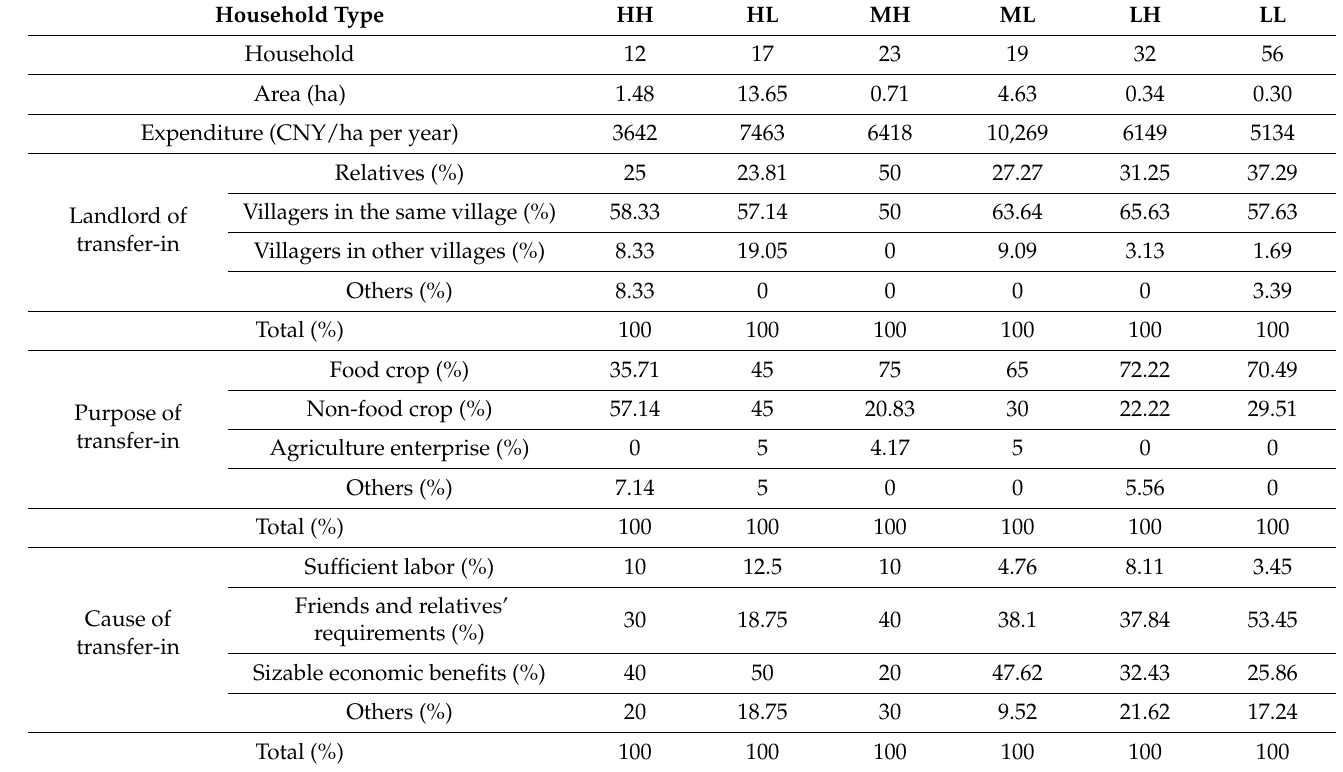
Table 10. Land transfer-in